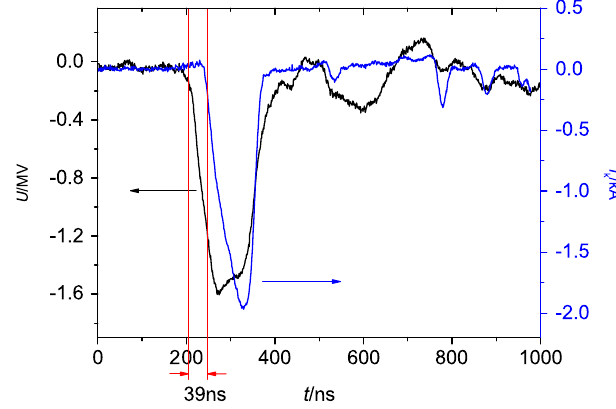
FIG. 9. CTT of the CNT cathode is 39